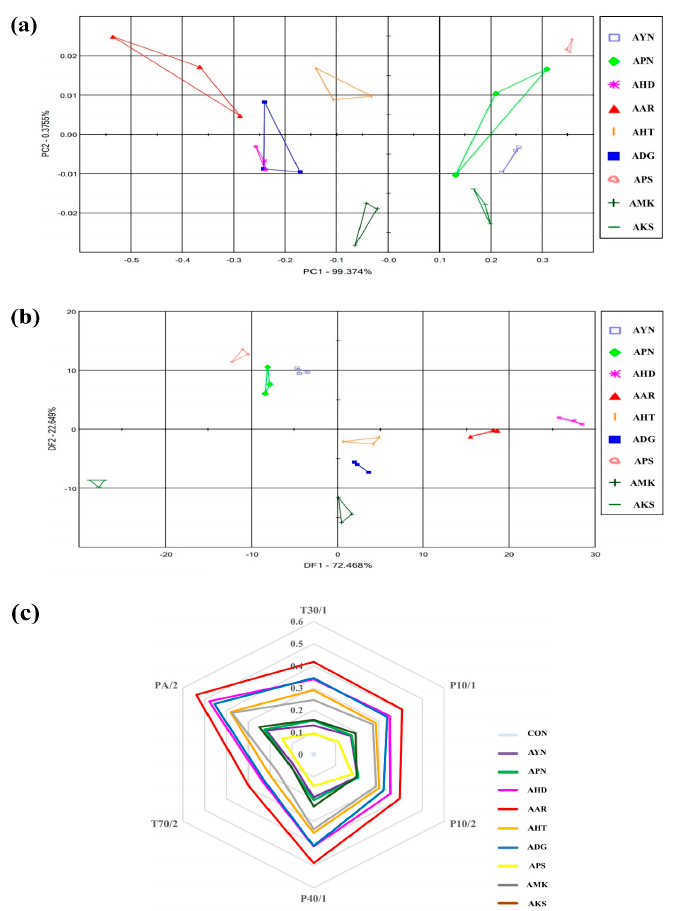
Figure 3. Floral scent patterns of nine Aster species are distinguished by principle component analysis ( a ) discriminant factor analysis; ( b ) radar plot representing the discrimination of floral scents of different Aster species by each sensor; ( c ) Aster yomena (AYN), Aster pseudoglehnii (APN), Aster hispidus (AHD), Aster arenarius (AAR), Aster hayatae (AHT), Aster danyangensis (ADG), Aster pilosus (APS), Aster maackii (AMK), Aster koraiensis (AKS).